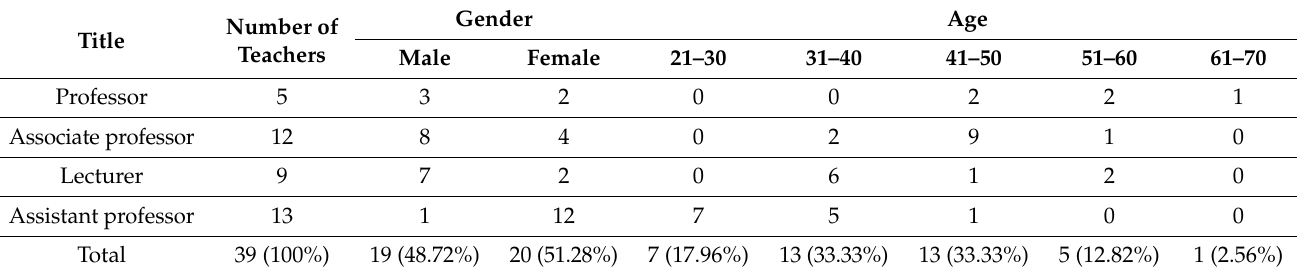
Table 2. Gender, age, title, and number of teachers within the Marketing specialization, undergraduate